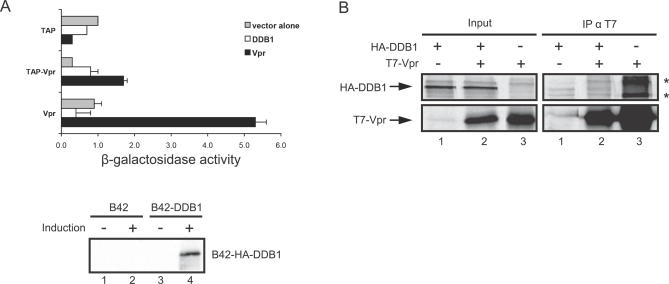
Absence of Direct Vpr Binding to DDB1 in Yeast(A) The EGY48 reporter strain containing LexA-TAP, LexA-Vpr, or LexA-TAP-Vpr (“bait”) was transformed with B42, B42-DDB1, or B42-Vpr–expressing plasmid (“prey”). The binding affinity between the different proteins was assessed by assaying β-galactosidase activity using the o-nitrophenyl-β-D-galactopyranoside method. Histograms represent averaged data from 2–4 different clones and are representative of two independent assays. Western blot analysis of induced and non-induced B42-HA-DDB1 expression in the B42 and B42-DDB1-transformed EGY48/LexA-Vpr reporter strain is shown below.(B) In vitro–translated T7-Vpr was immunoprecipitated with an anti-T7 antibody in the presence or absence of in vitro–translated HA-DDB1. Amounts of protein initially added to the assay (input) are shown in the left panel. * represents non-specific proteins immunoprecipitated by the anti-T7 antibody.